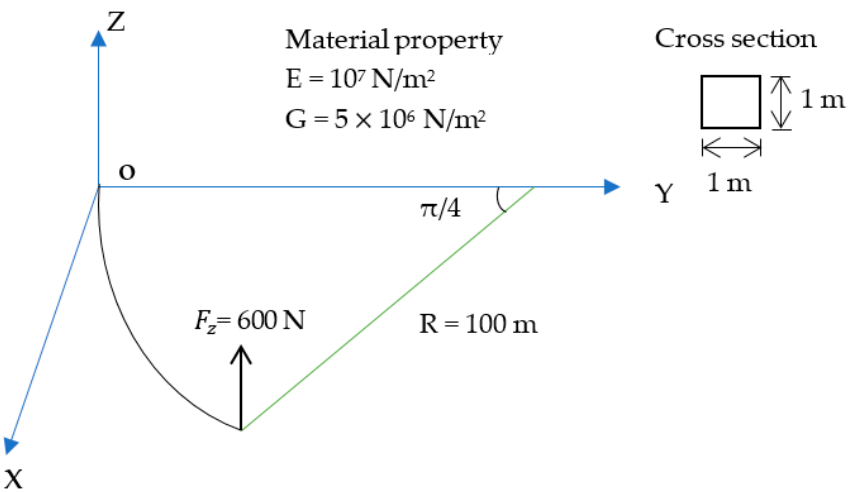
Figure 8. Cantilever beam 45-degree bend with an upward concentrated load. Figure 9, solved by 31 nodal points with 10 loading increments, shows the evolution of tip displacement as a function of the applied load modulus. The number of iterations is fewer than five within each increment. Table 1 shows the free end position of the initial curved cantilever beam under out-of-plane force. A comparison of the free end position from these references is also given in Table 1. The results show that the present theory can provide accurate solutions.